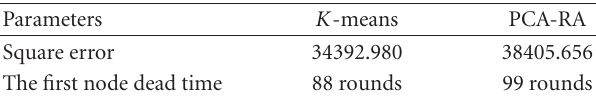
throughput compared with LEACH-E and 114.12% increase about throughput compared with LEACH.